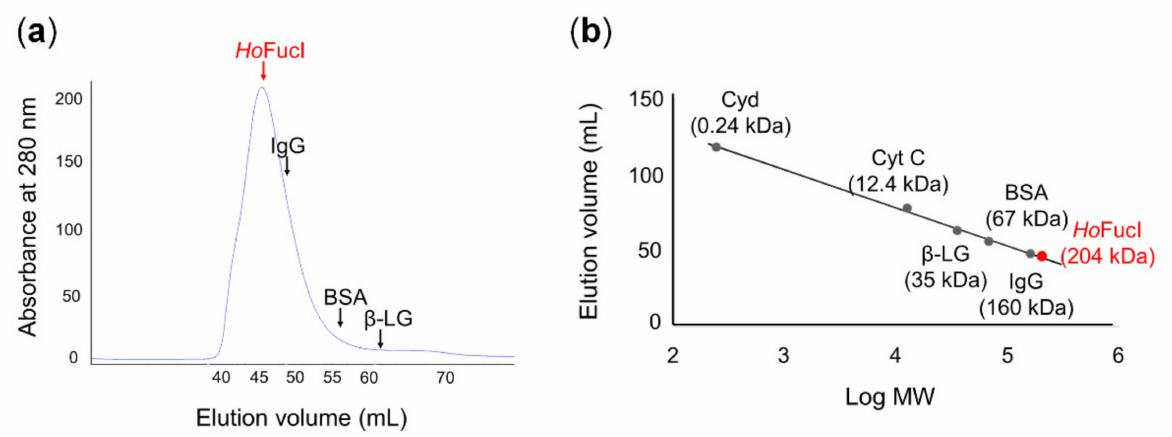
Figure 2. ( a ) Size-exclusion chromatography profile of L -fucose isomerase ( L -FucI) from Halothermothrix orenii ( Ho FucI). ( b ) Calibration curve obtained using various protein standards (cy- tidine [Cyd], cytochrome C [Cyt C], β -lactoglobulin [ β -LG], bovine serum albumin [BSA], and immunoglobulin G [IgG]) to determine the native molecular mass of Ho